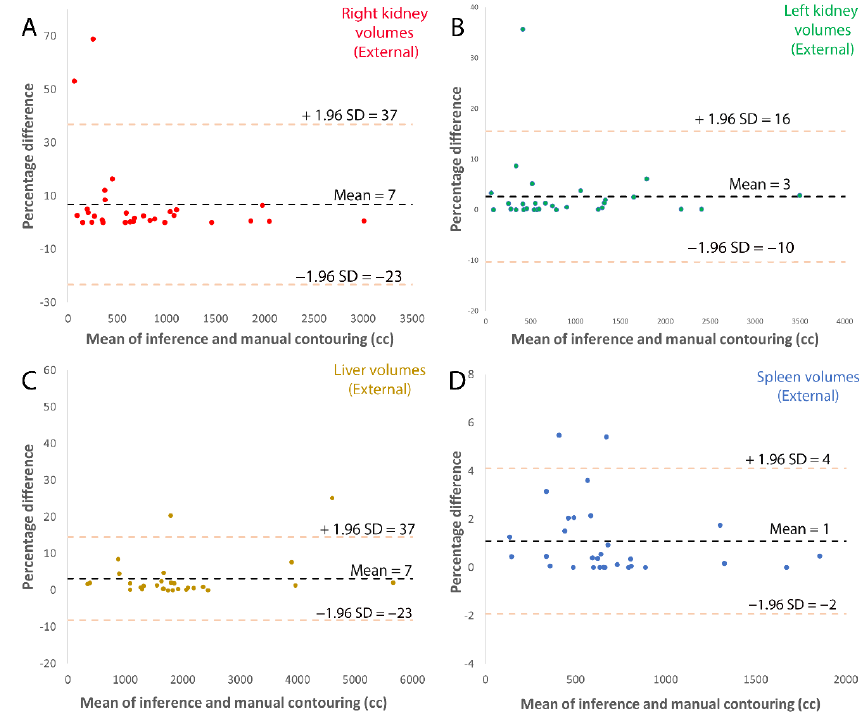
Figure 4. Bland-Altman plots of external validation comparing the inference volume with radiologist corrected volume for ( A ) left kidney, ( B ) right kidney, ( C ) spleen and ( D ) liver.